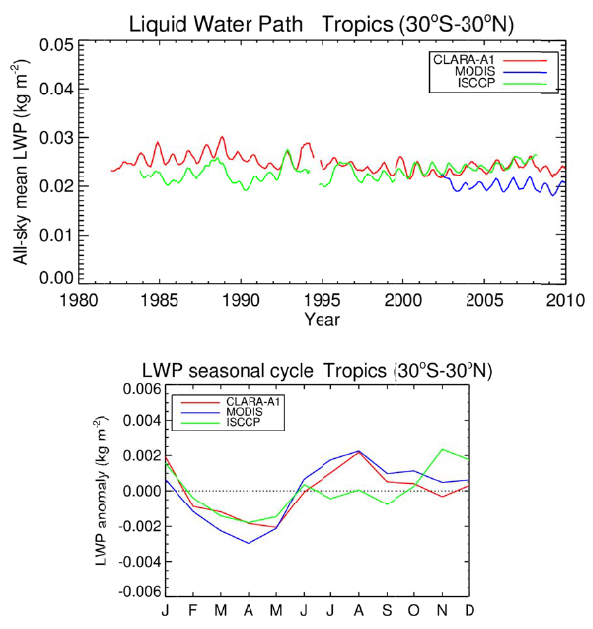
Fig. 5. Comparison between CLARA-A1, MODIS, and ISCCP all- sky liquid water path (kg m − 2 ) for the tropics (30 ◦ S–30 ◦ N): 6- months running-mean time series (top) and average seasonal cycle calculated from the years 2004–2007 (bottom) The time series have been compiled from the NOAA afternoon satellites (NOAA-7, -9, - 11, -14, -16, and -18) for CLARA-A1, the MODIS-Aqua (MYD08, LWP based on the 2.1µm channel) product, and the mid-afternoon time slot of the ISCCP submission to the GEWEX Cloud Assess-